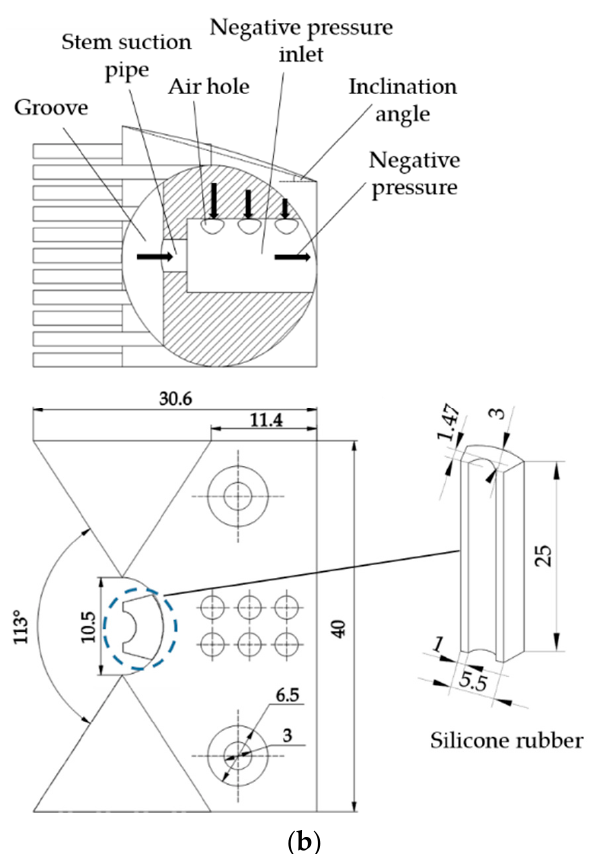
Figure 4. Clamping mechanism: ( a ) 3D model of Clamping mechanism; ( b ) engineering drawing of clamping block “b” (unit: mm). 1. Silicone rubber. 2. Positioning piece. 3. Seedling. 4. Air hole. 5. Connecting hole. 6. Negative pressure inlet.